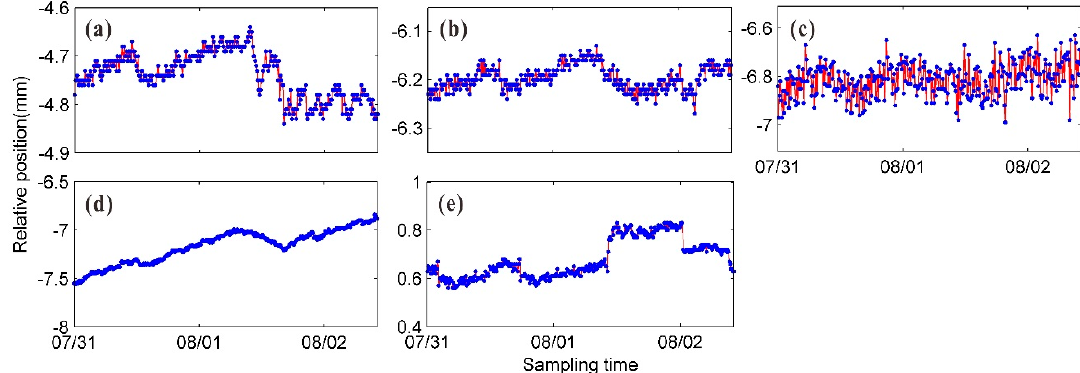
Figure 13. Deformation series at five elevation positions of dam central axis, as measured by reversed pendulum device: ( a ) 65 m ( b ) 105 m, ( c ) 122 m, ( d ) 145 m, and ( e ) 169 m.